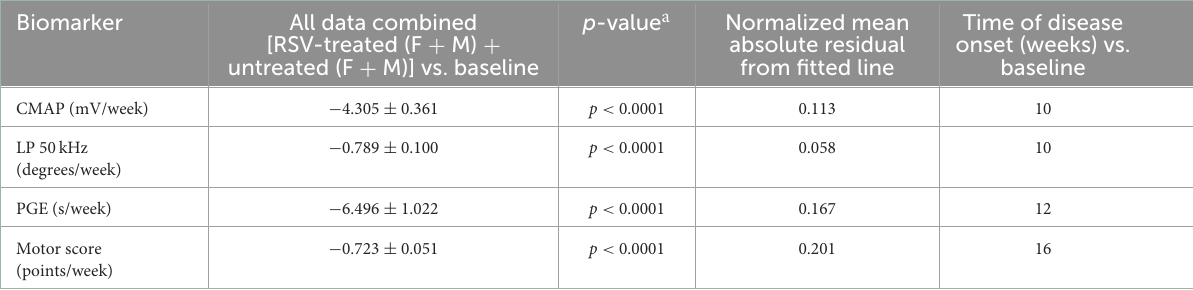
TABLE 3 Rates of change for CMAP amplitude, LP 50kHz, PGE, and motor score for combined [RSV-treated (F + M) + untreated (F + M)] vs. baseline. Biomarker